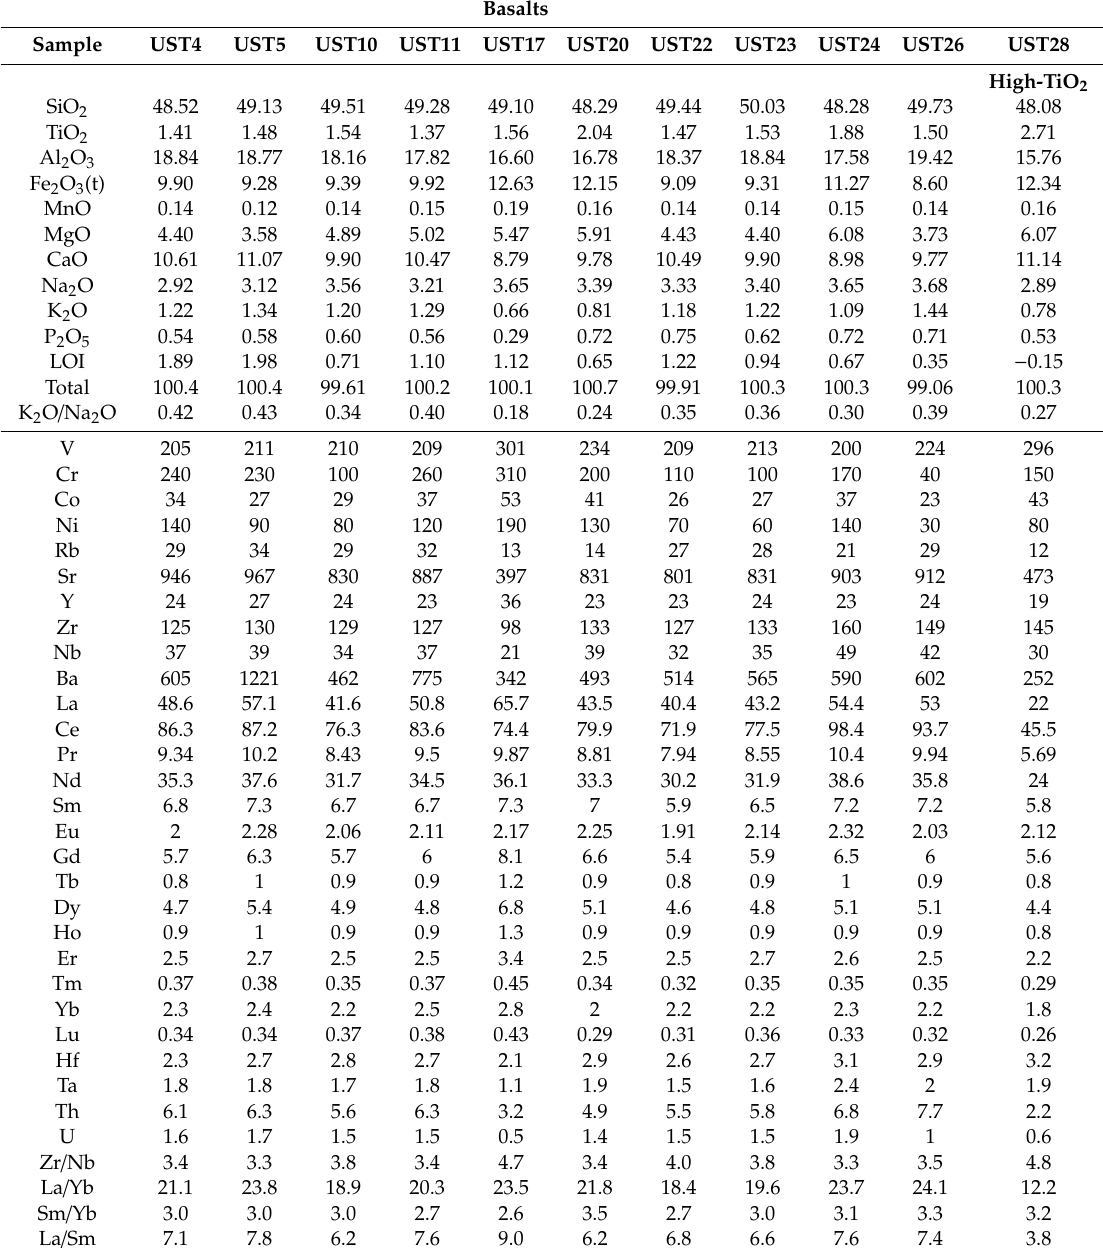
Table 2. Major (wt%) and trace elements (ppm) contents of the investigated millstones—basalts of the Na-Alkaline series.